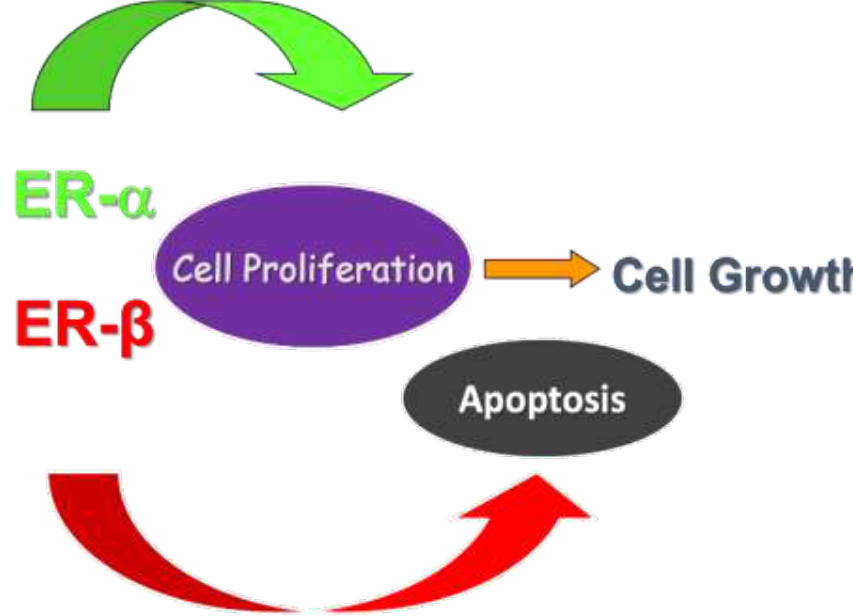
Figure 1. Evidence from the literature shows that the stimulation of ERα leads to activation of pathways involved in cell proliferation. On the other hand, ERβ promotes cell apoptosis in colon, thus inhibiting cell replication and tumoral